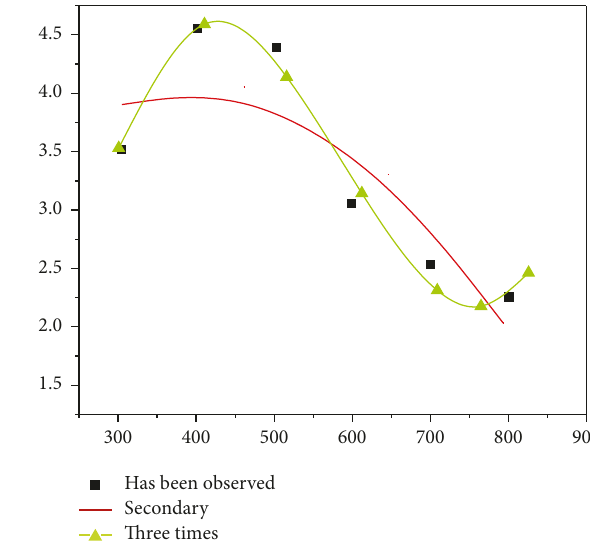
Figure 12: Fitting diagram of quadratic cubic function curve equation.